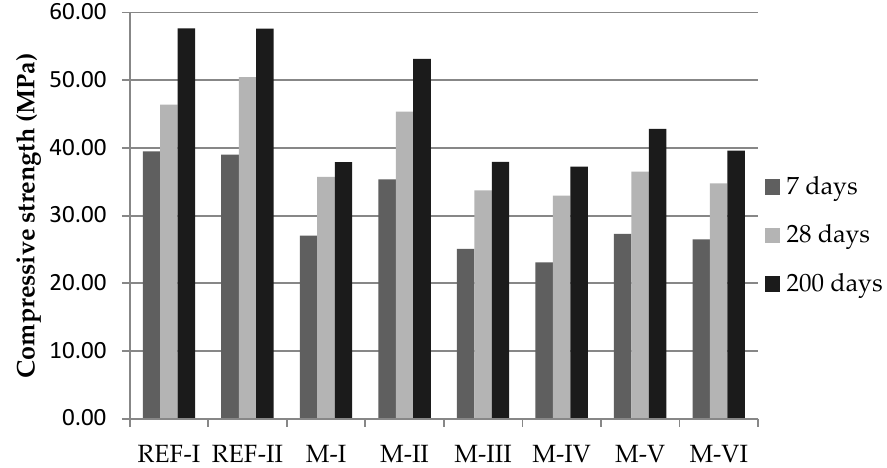
Figure 6. Compressive strength of the mortar mixes.